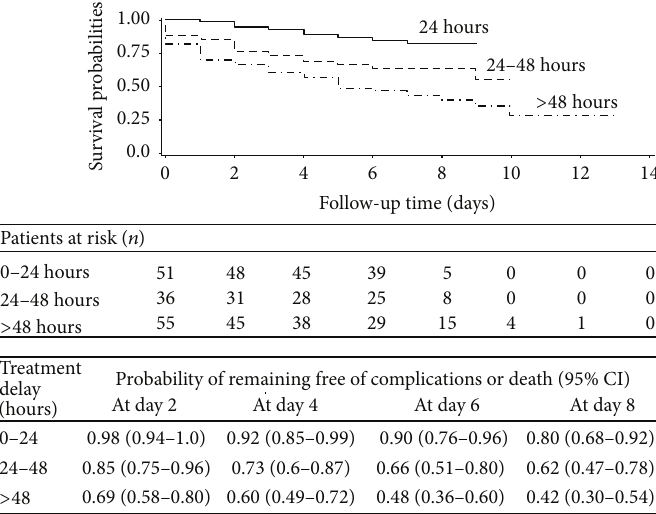
Figure 2: Kaplan Meier curves of probability of remaining free of postoperative complications or death according to the delay of treatment and length of hospital stay since surgical intervention.